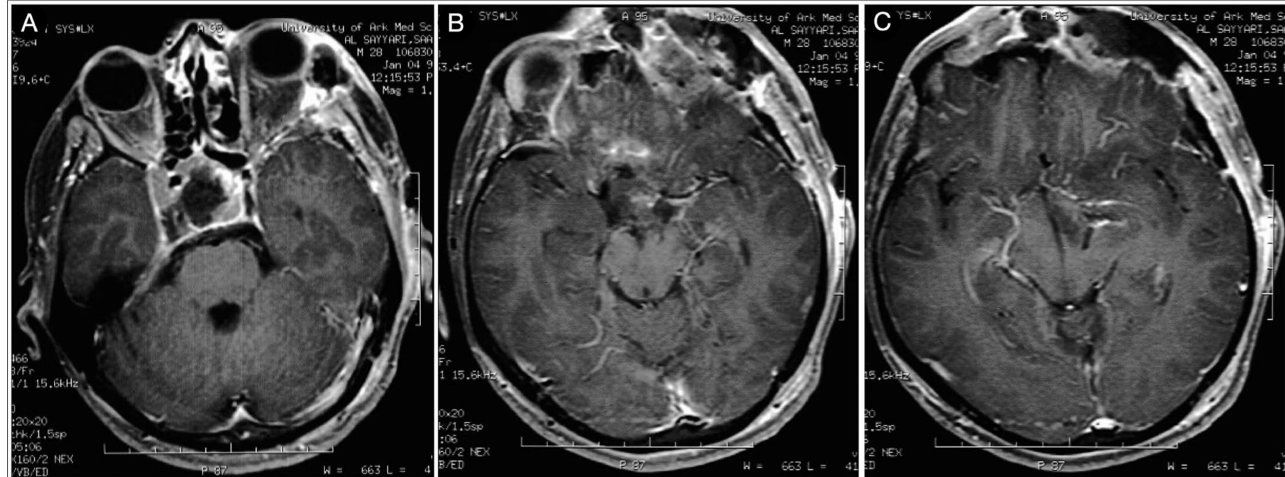
Figure 12. ( A – C ) Postoperative axial T1-weighted contrast-enhanced MRI. Scale bar: 5 cm.